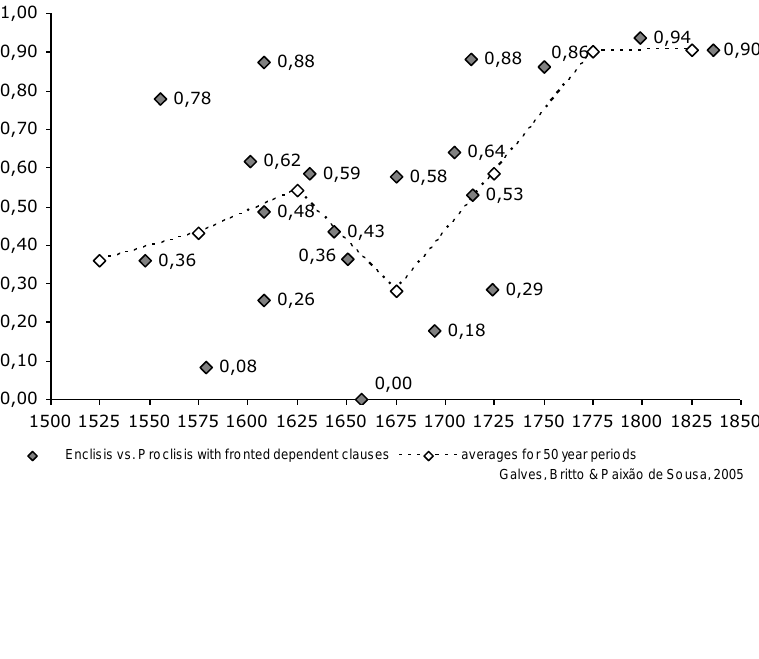
Galves, Britto & Paixão de Sousa,